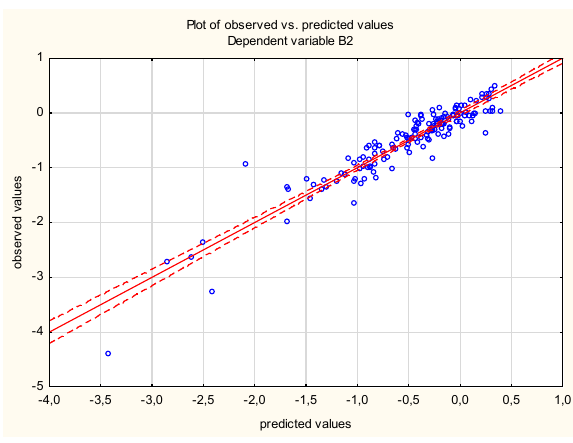
Figure 3: Plot of observed vs. predicted values (for model 7